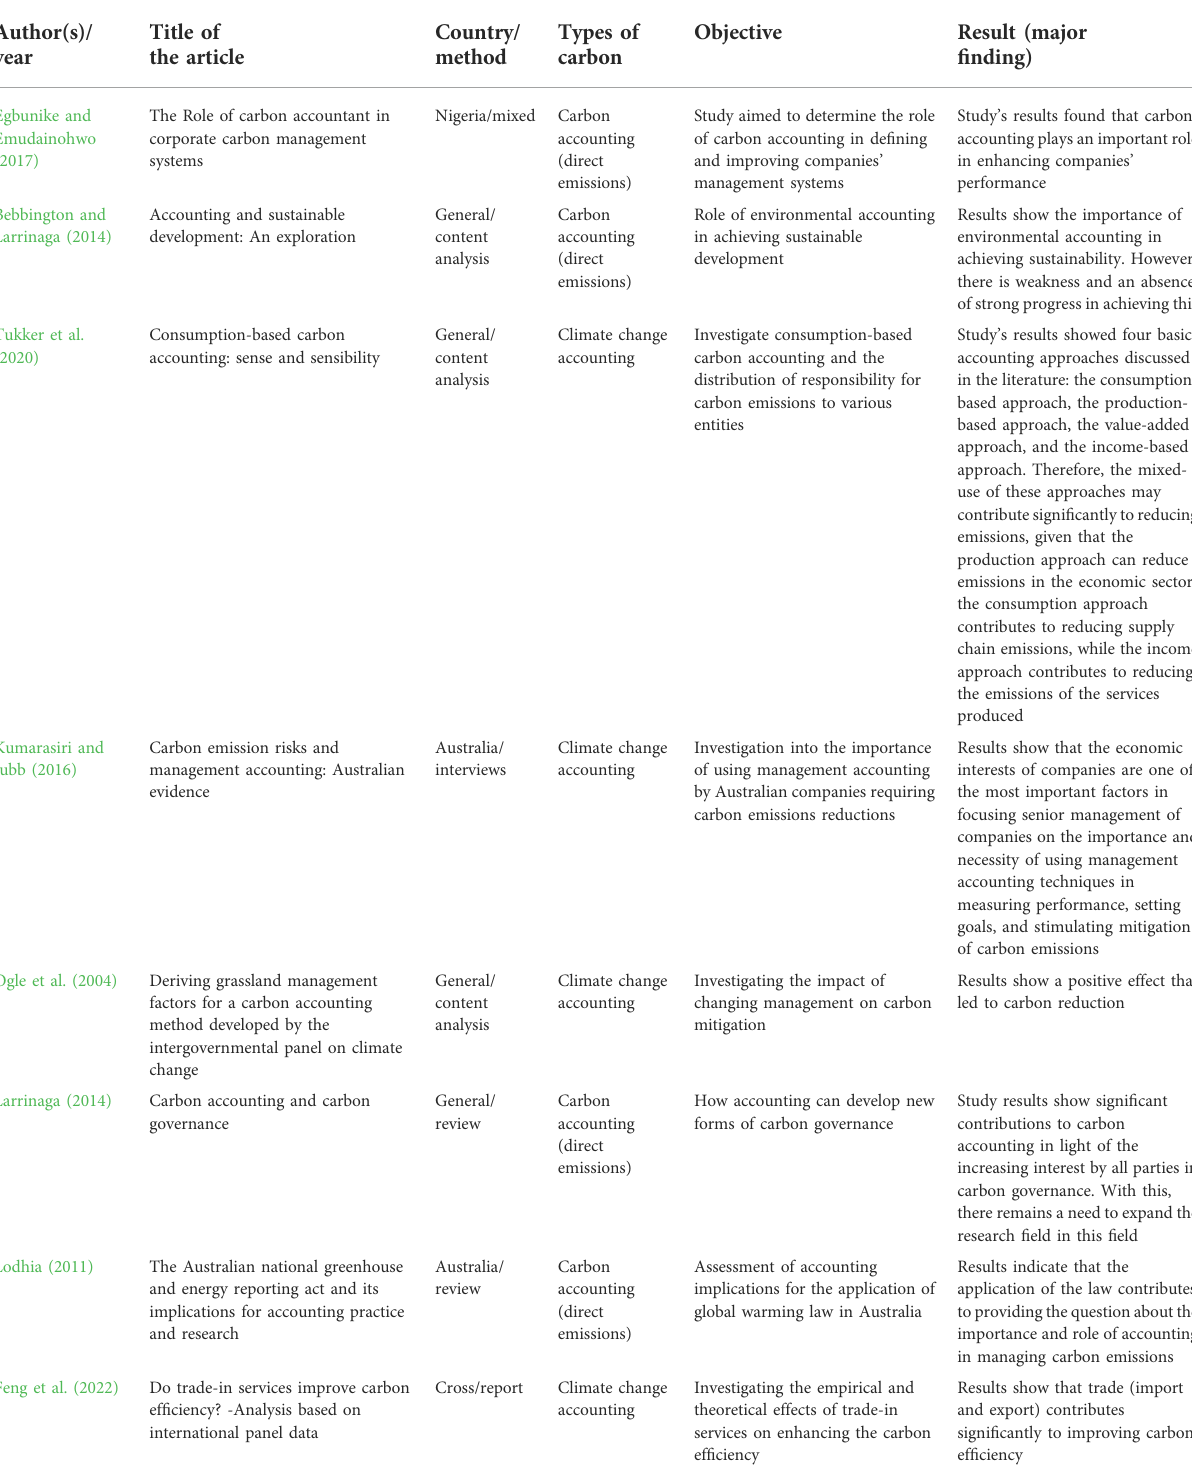
TABLE 6 Summary of the major existing studies regarding product scale 7 study